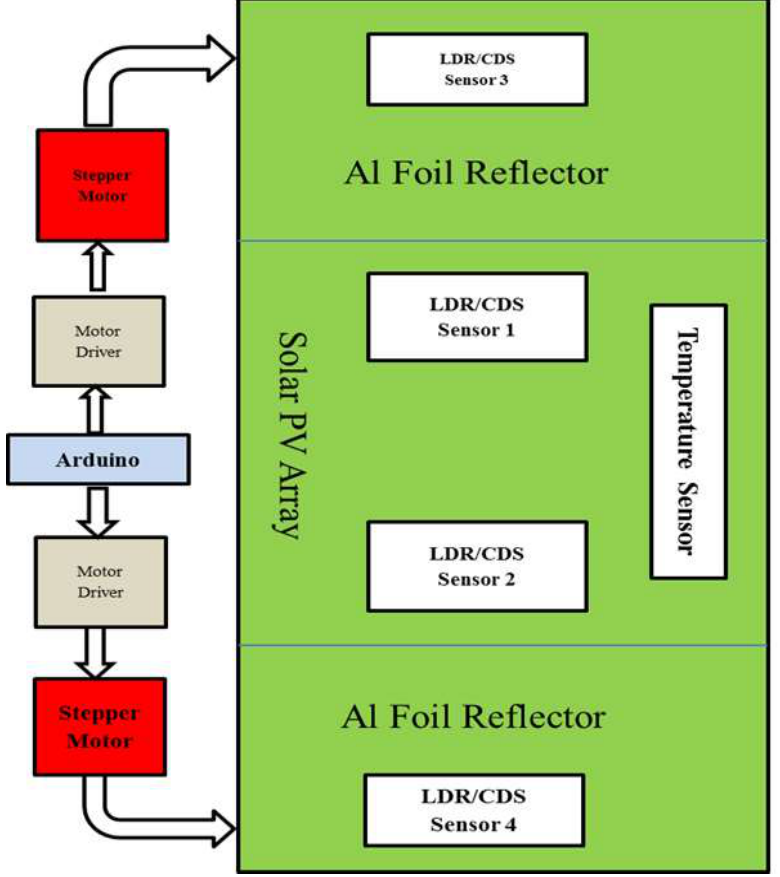
Figure 7. Scheme for control and hardware implementation of Al-BRS.